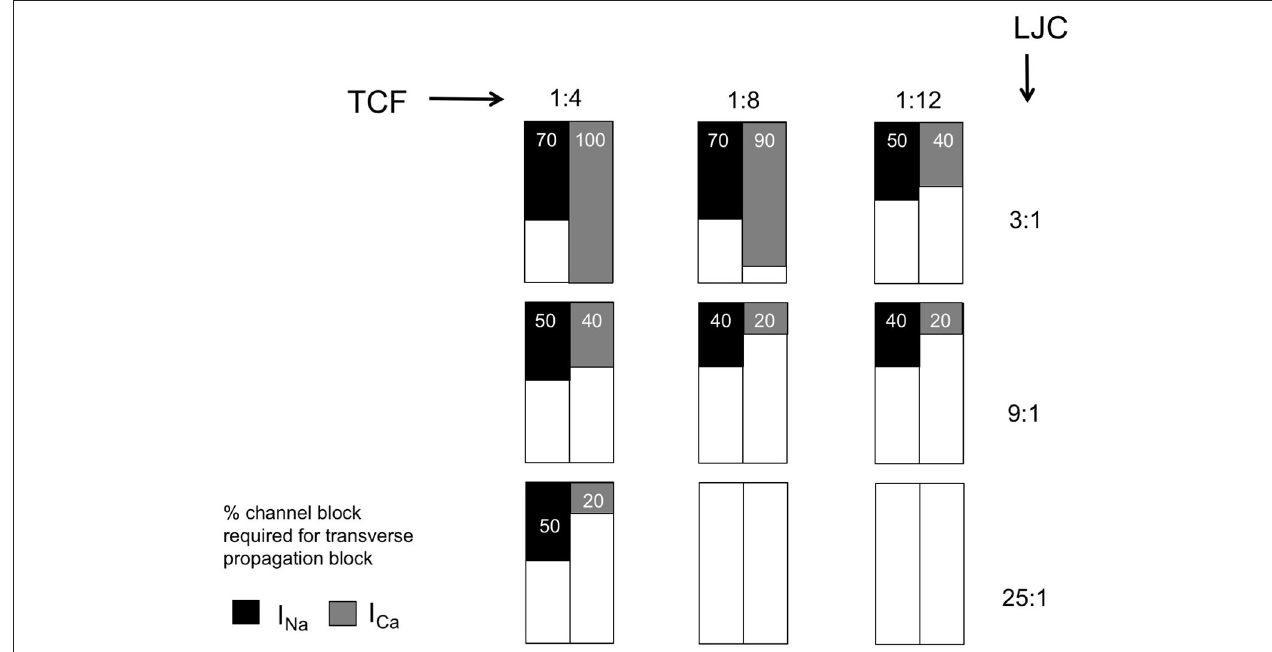
FIGURE 4 | Sensitivity of transverse propagation to sodium and calcium current (I Na and I Ca ) block. Summarizing table with entries representing the minimal percentage of channel block required for transverse block with varied discrete TCF and LJC.